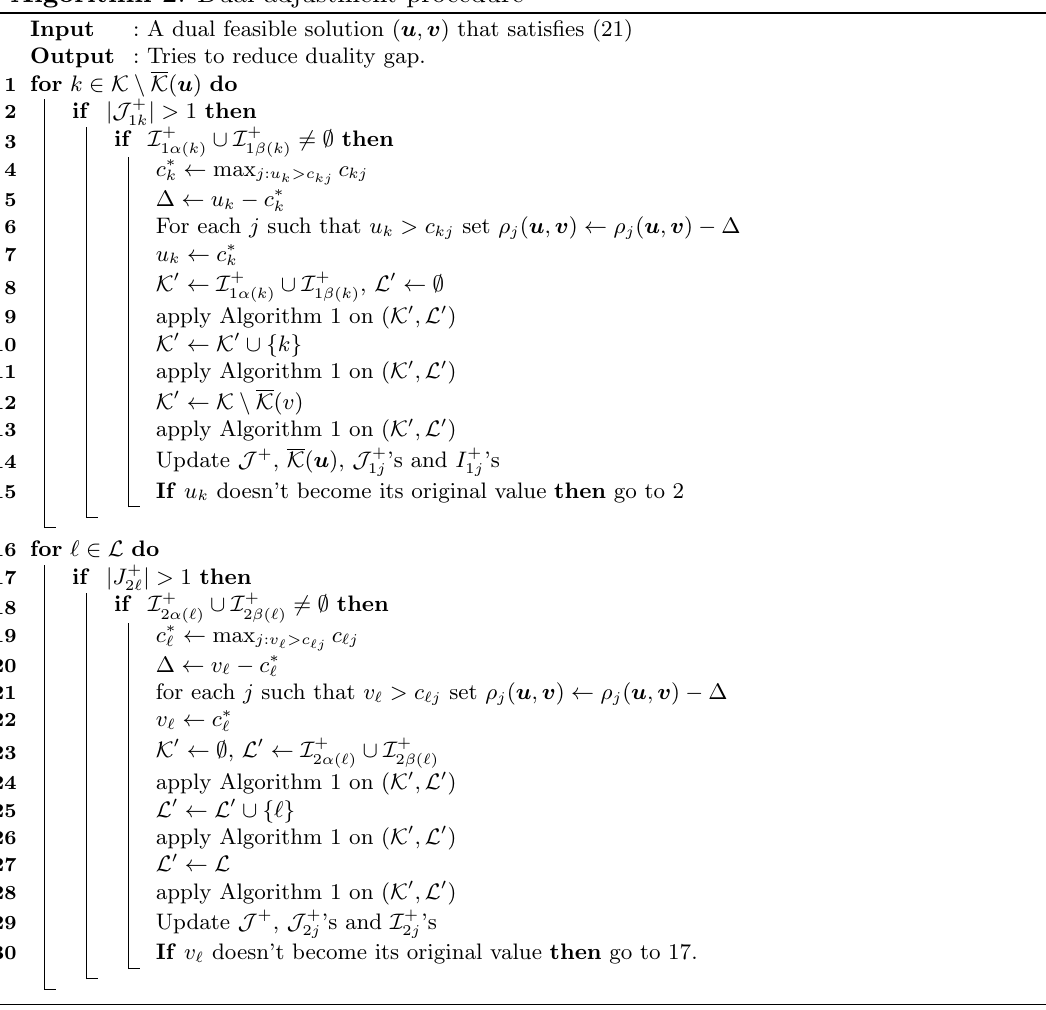
Algorithm 2 : Dual adjustment